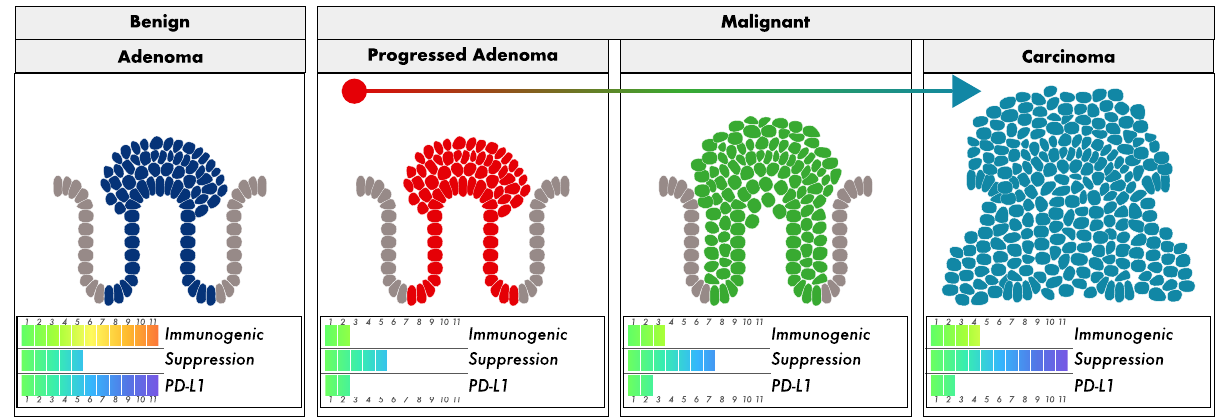
Fig. 10 Progressed adenomas construct an immunosuppressive niche. This suggests that benign CRA are stuck at the immunogenic bottleneck. CRA that do progress instead appear to initially survive using the Get Lucky strategy, while eventually shifting to a Get Smart one as immune suppression strengthens. As immune escape relaxes selection against antigenicity, colorectal carcinomas (CRC) rely less on Get Lucky, and are able to accumulate neoantigens, increasing neoantigen burden. These conclusions are consistent with the observation that antigenicity and cytotoxic T cells are good prognostic markers, but also suggest that altering the immunosuppressive ecology, as opposed to targeting checkpoint inhibitors, may prove to be a more successful treatment